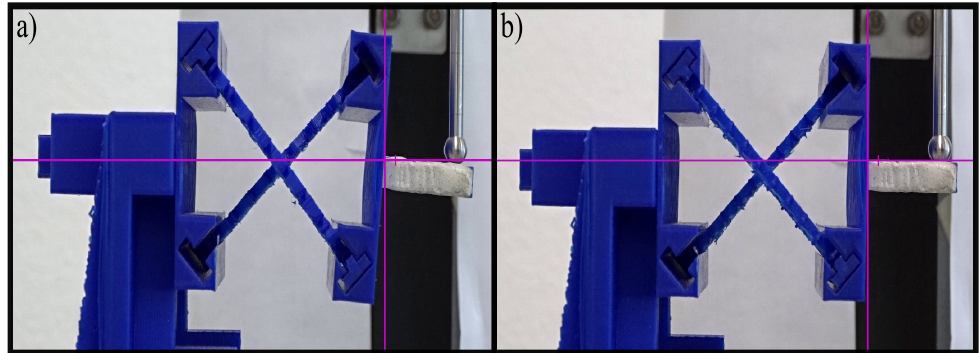
Figure 14. Comparison between the higher and lower displacements obtained from the studied latticed compliant cross-axis joints with a force applied of 0.04905 N. ( a ) Latticed compliant cross-axis joint with re-entrant lattice-flexure hinges with the unit cell at 60° orientation. ( b ) Latticed compliant cross-axis joint with square lattice-flexure hinges with the unit cell at 0°